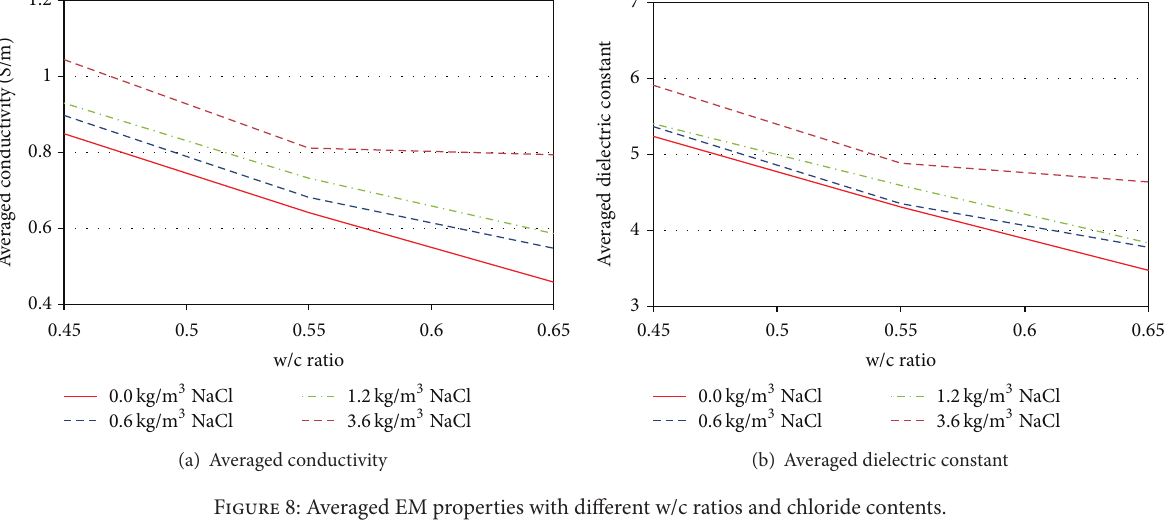
Figure 8: Averaged EM properties with different w/c ratios and chloride contents.